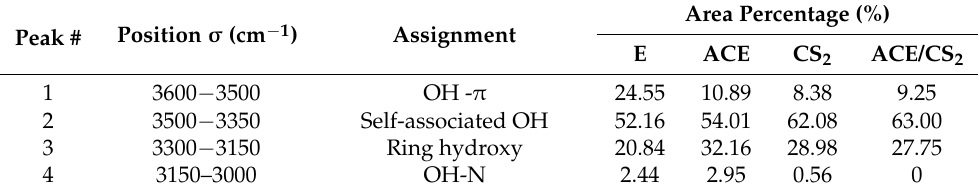
Figure 10. Infrared spectra of the original and extractive residues in the 3000–3600 cm − 1 region. (( a ) is an original tar residue fit, ( b ) is a fit to carbon disulphide, ( c ) is a fit to acetone and ( d ) is a fit to a mixed solvent. The red line is the fit line and the blue line is the sub peak). Table 10. Infrared spectra of four samples 3000–3600 cm − 1 split peak fitting ratio of each absorption peak area.